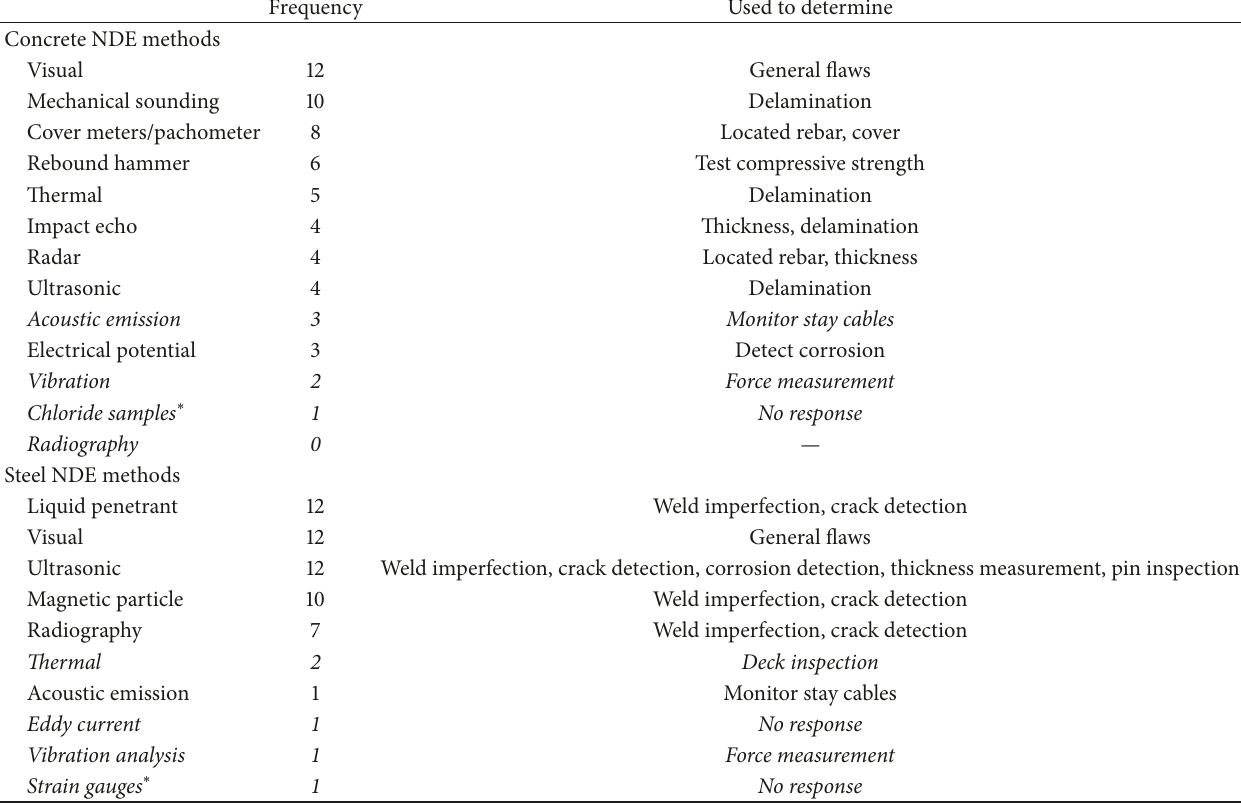
Table 1: Number of respondents indicating experience with and types of damage identified with each NDE method.